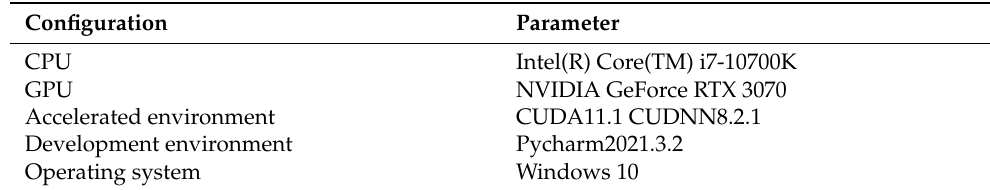
Table 2. Experimental